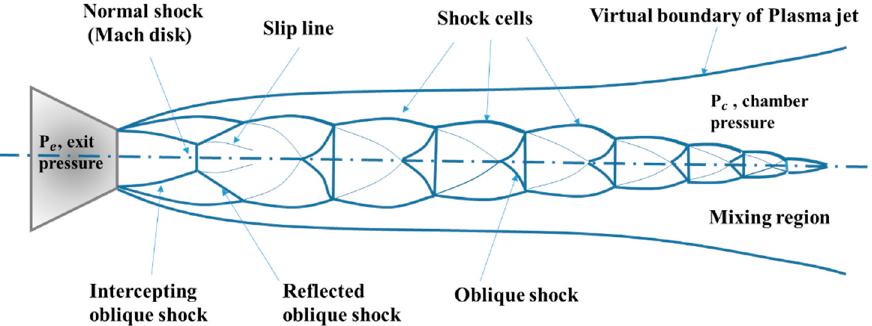
Figure 4. Schematic of the highly under-expanded jet adapted from [39].